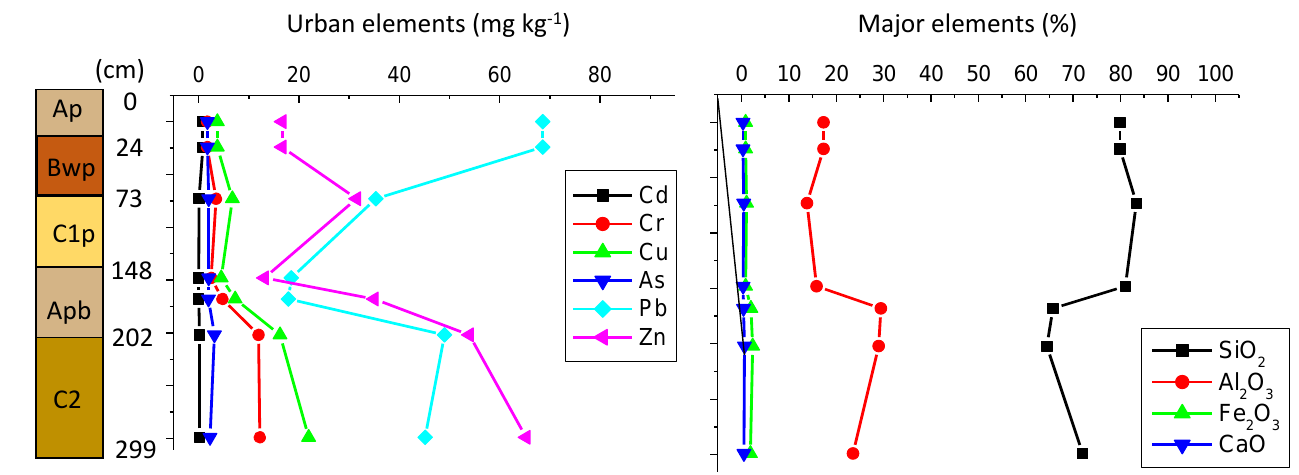
ied soil profile.